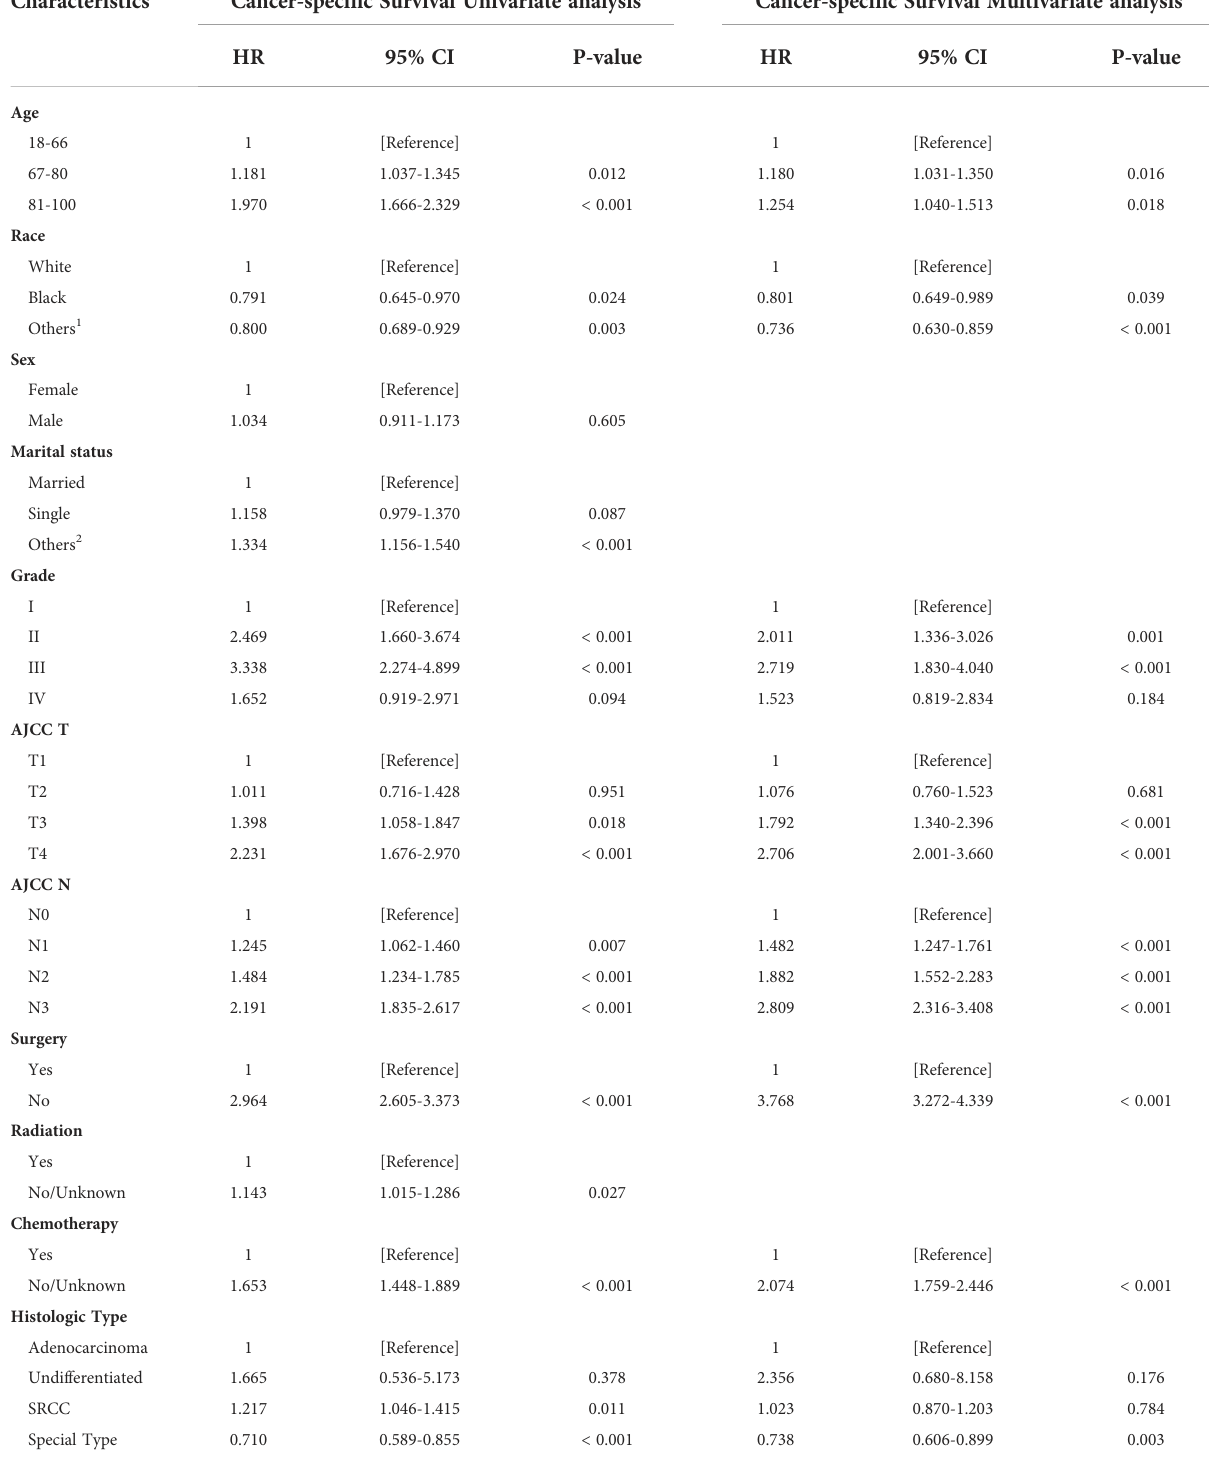
TABLE 3 Cancer-speci fi c Survival Univariate analysis and Multivariate analysis of the training